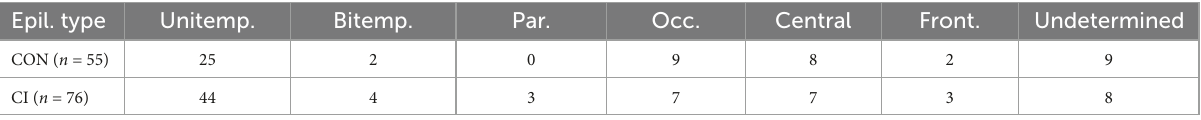
TABLE 1 Types of epilepsy in patients with epilepsy used in the study. Epil.